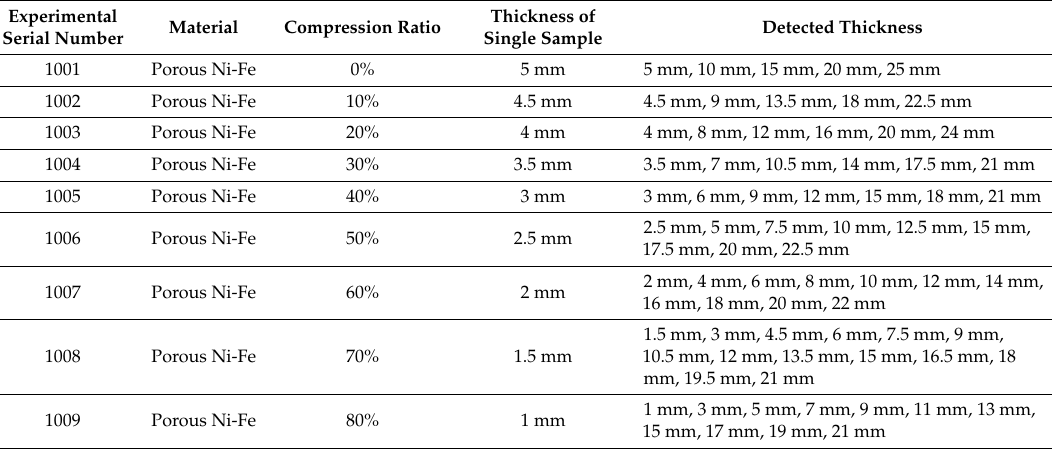
Table 1. Parameters in the measuring process of the sound absorption